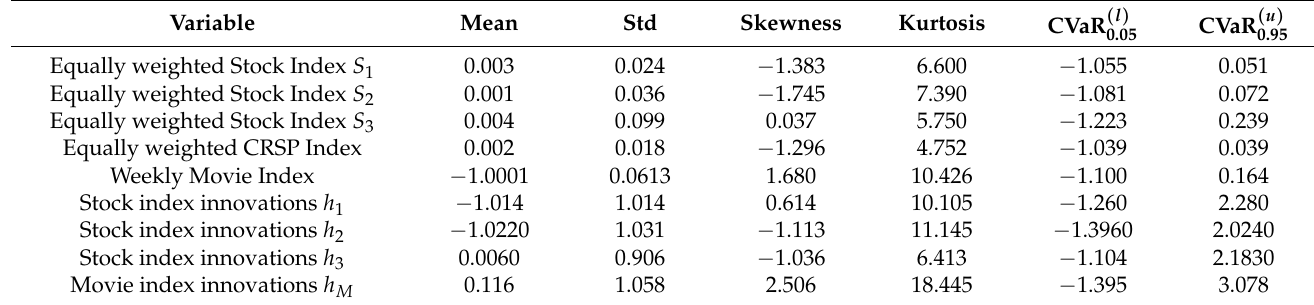
Table A4. Variables—Univariate